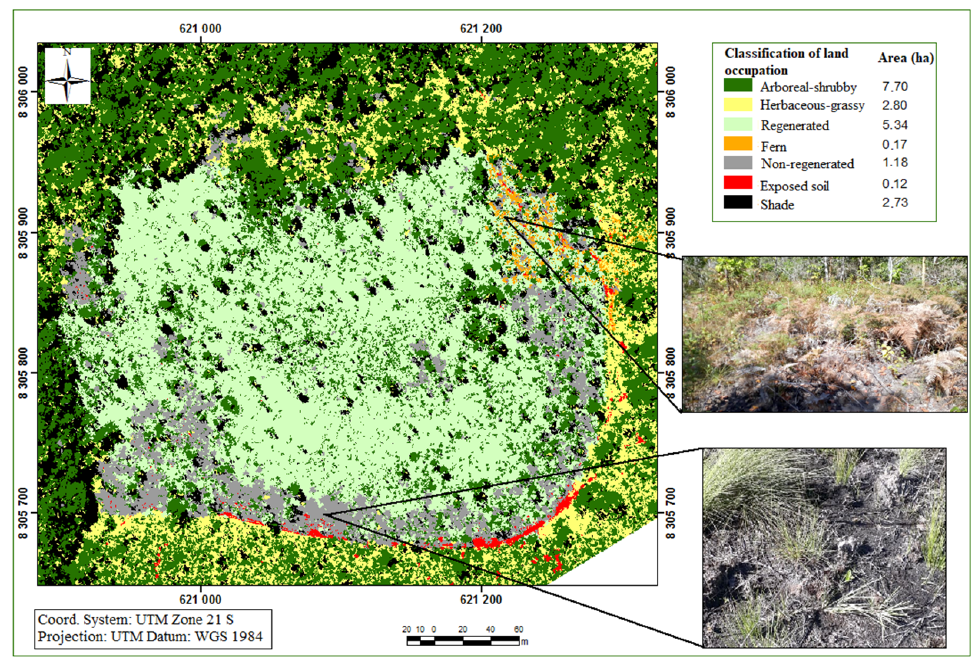
Figure 6. OBIA Classification of the orthomosaic image of 2 July